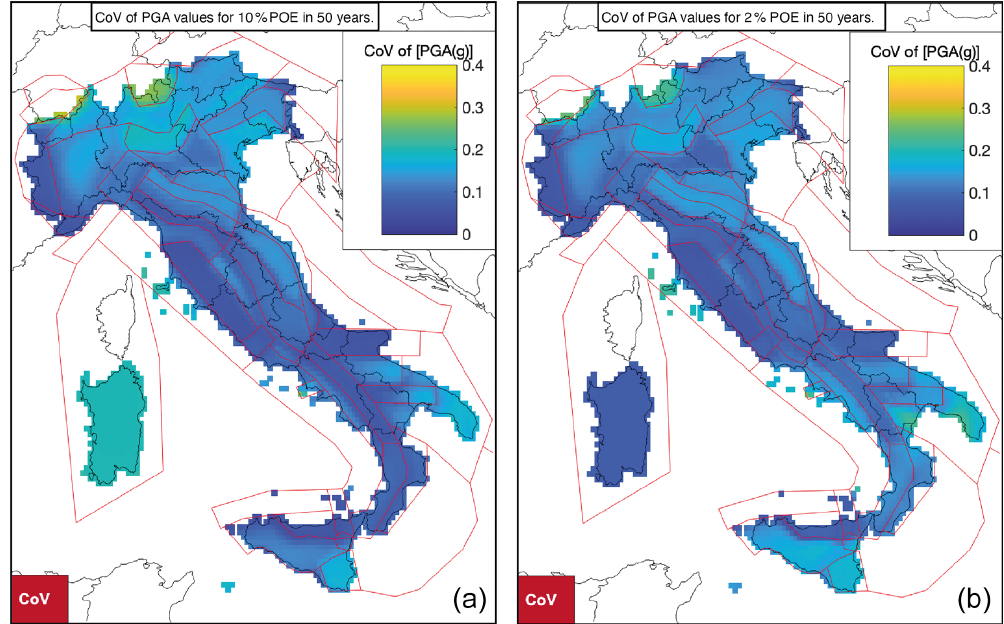
Figure 12. Spatial distribution of the coefficient of variation (CoV) of PGA values for 10% (a) and 2% (b) probabilities of exceedance in 50